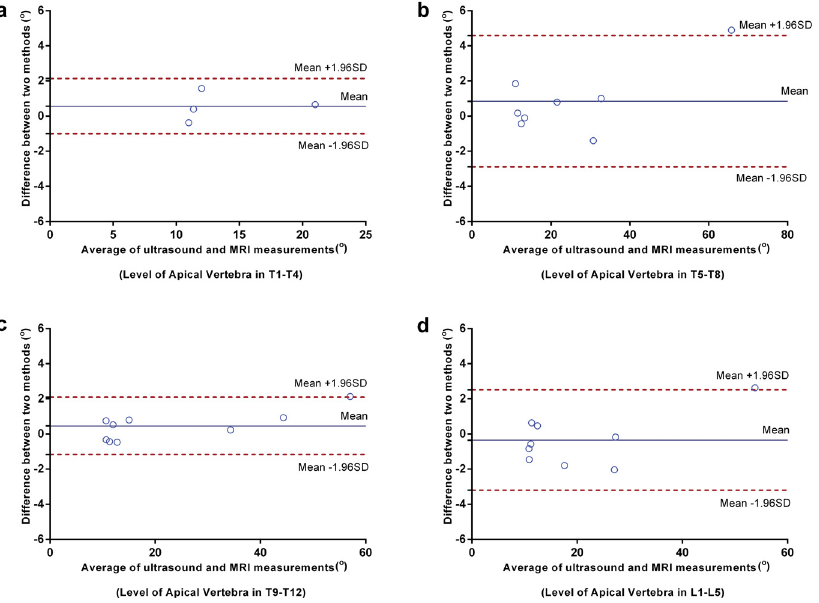
Fig 6. Bland – Altman plot assessing the agreement of coronal curvature measurements using ultrasound and MRI in the sample categories. (a) Level of apical vertebra in T1-T4; (b) Level of apical vertebra in T5-T8; (c) Level of apical vertebra in T9-T12; (d) Level of apical vertebra in